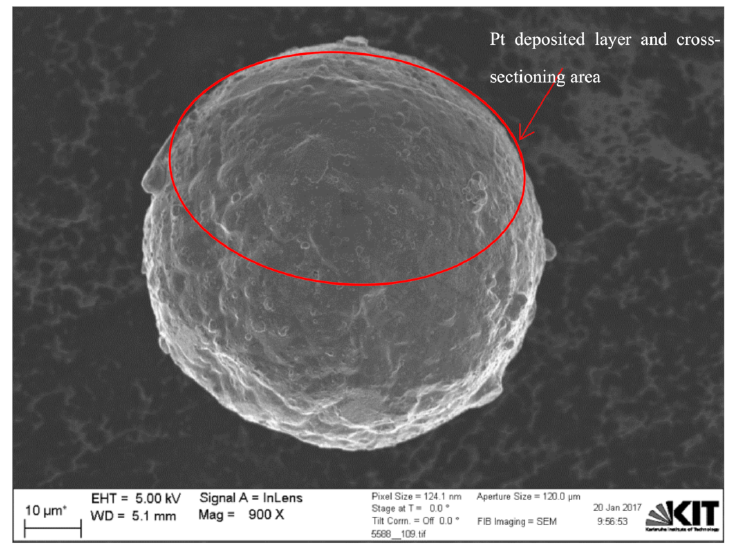
Figure 5. Pt coating and cross-sectioning area of a Cu particle using dual beam FIB-SEM characterization.